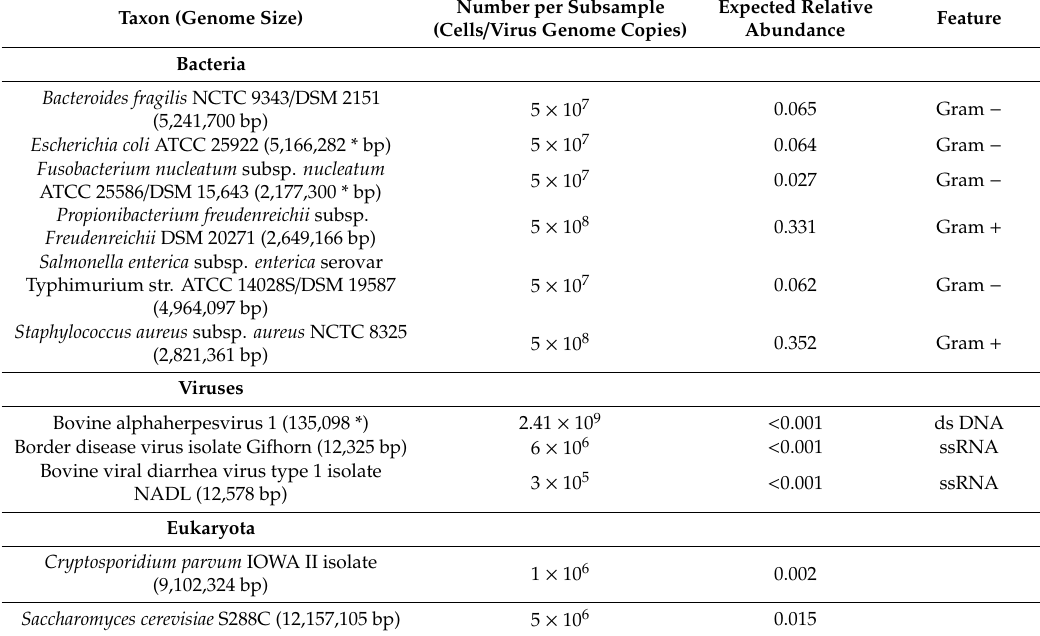
Table 1. Composition of the mock community used to spike the samples of cold smoked salmon and concentration of each microorganism. Each concentration corresponded to an expected relative abundance calculated by the number of cells of each spiked microorganism multiplied for the genome size, as indicated in the GeneBank (https: // www.ncbi.nlm.nih.gov / assembly), taking the value available or the mean * of the di ff erent values available for the same strain. The relative abundances were obtained by normalizing the resulting values to a sum of